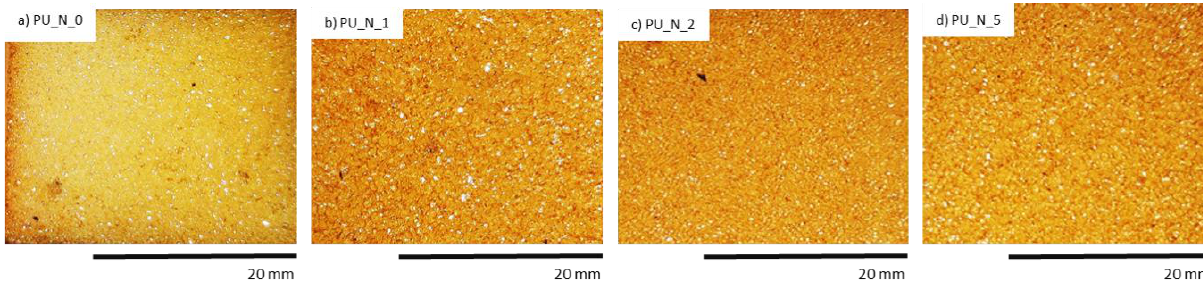
Figure 10. The cellular structure of ( a ) PU-0, ( b ) PU-1, ( c ) PU-2 and ( d ) PU-5 observed at a magnifi- cation of ×50. Adapted from Ref. [9]. The applied microbiological analyzed was carried out to estimate the action of clove filler on the antimicrobial characteristic of PUR samples (Table 8). A meaningful removal of selected bacteria — E. coli and S. aureus was seen after 24 h of exposure. A sample con- taining 5 wt.% of clove filler had the best results. The reduction in the selected bacteria using 5 wt.% of clove filler was about 76 and 79%, which clearly indicates a strong fungi- cidal and microbicidal effect, protecting composites against bacteria and fungi.